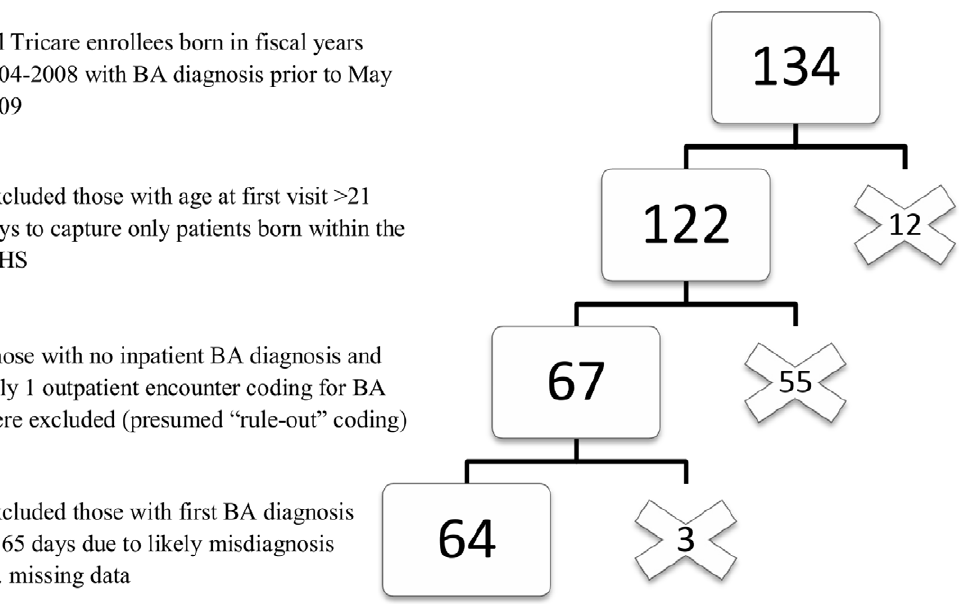
Figure 1. Exclusion algorithm for identification of biliary atresia patients in the MHS. MHS=Military Health System; BA=Biliary Atresia.